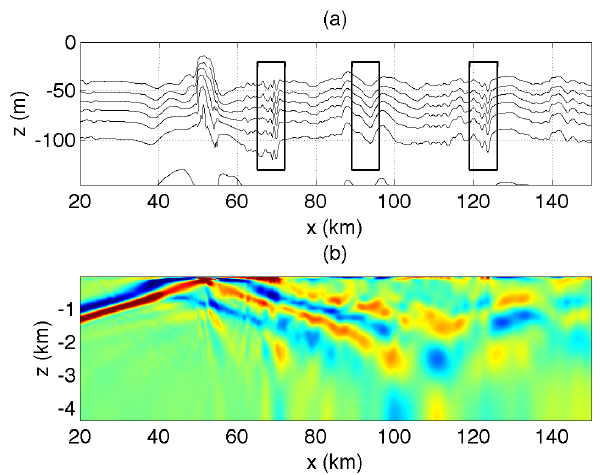
Fig. 3. Caption as for Fig. 2, but for E2, 11 . 5 M2 periods after the start of the simulation. The three main wave trains are framed in (a) and have all been generated one M2 period after each